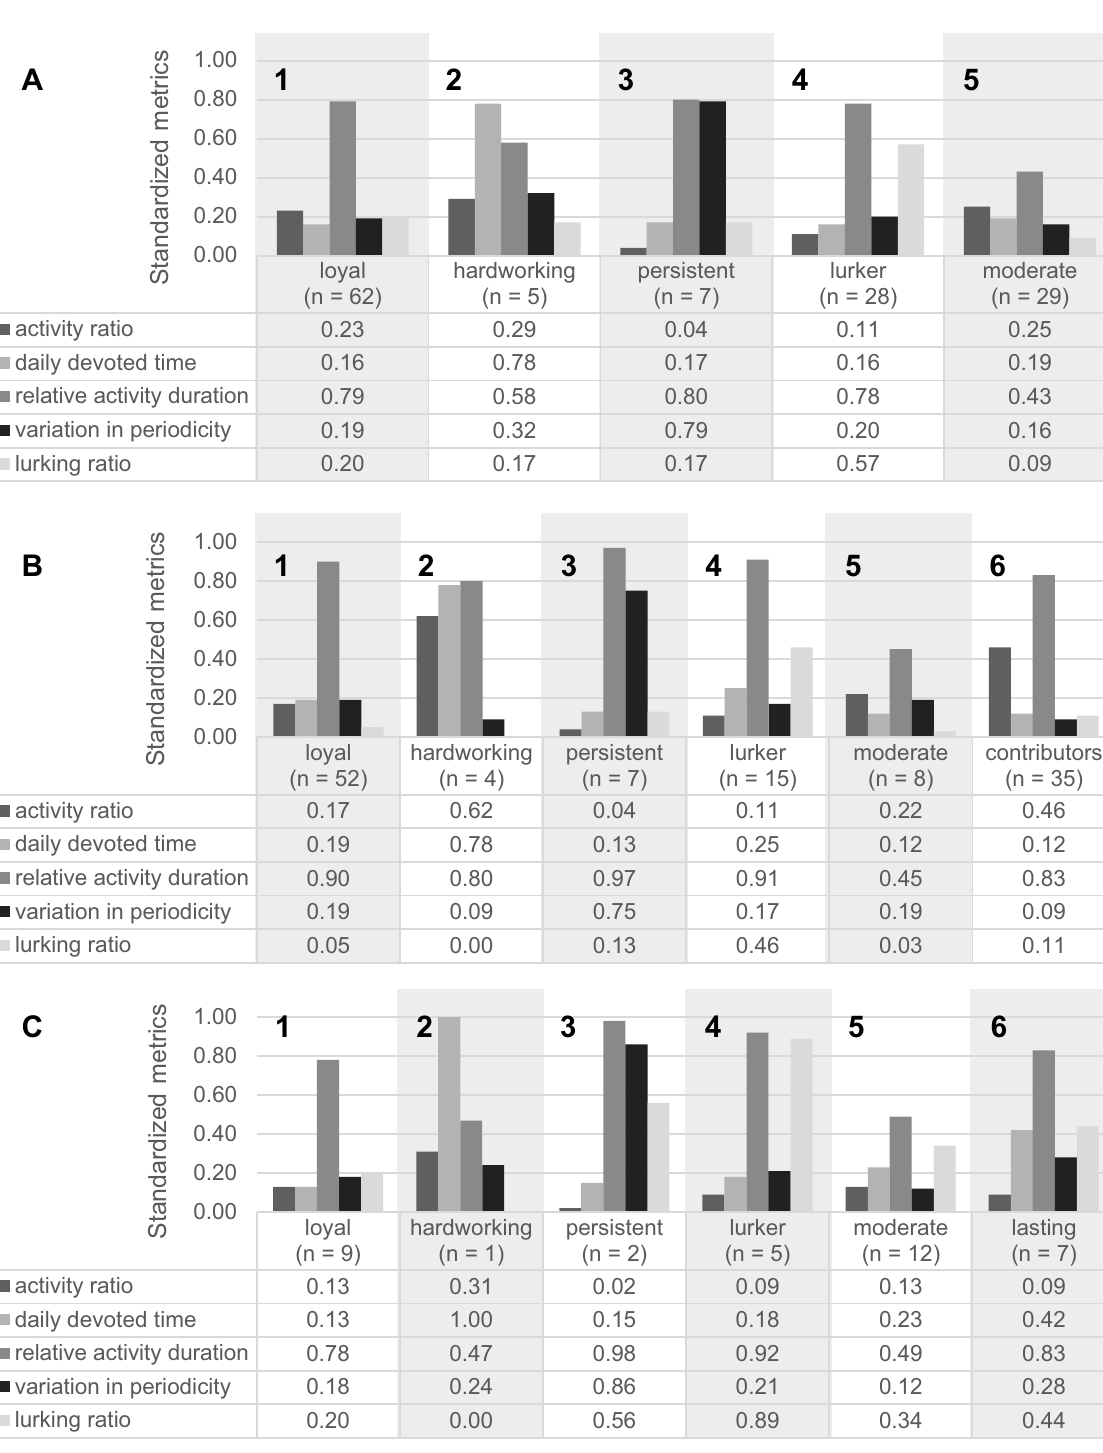
Fig 2. Engagement profiles for participants. Engagement profiles (A) within the ‘Wildlife Researchers 1’ project ( N = 131) and the two phases of (B) data collection ( n 1 = 121) and (C) data analysis ( n 2 = 36) for participants with more than two active days are based on the standardized engagement metrics for clustering [0; 1].